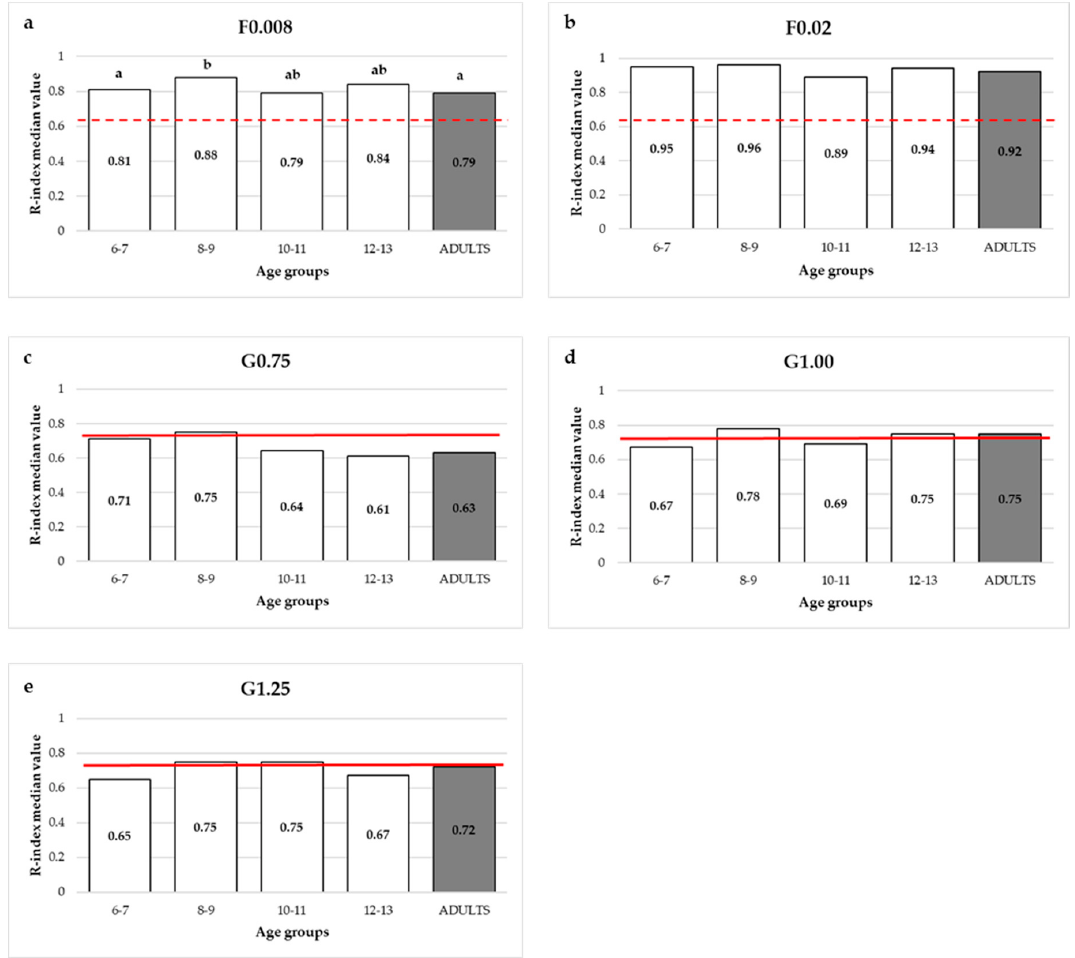
Figure 6. ( a – e ). R-index median values by age and tool. The full and dashed lines indicate, respectively, the R-index discrimination cut-offs for gratings (G) ( R = 0.74) and filaments (F) ( R = 0.63). Different letters indicate significant differences (Dunn-Bonferroni, p < 0.05).